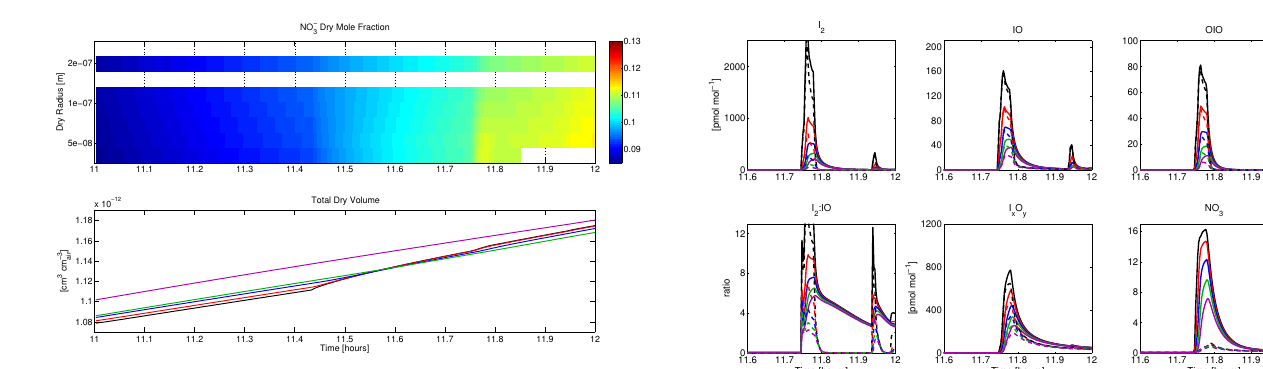
Fig. 12. Mixing ratios of I 2 , IO, OIO, I x O y , NO 3 , and ratio of I 2 :IO, at 3 in the lowest five layers of the model column for the two low photo, low tide, model runs. Dashed and solid lines are, respectively, for the standard chemistry scheme and the I 2 recycling scheme. Black, red, blue, green, and purple lines represent levels with their centres at 0.5, 2, 4.5, 8 and 12.5m,